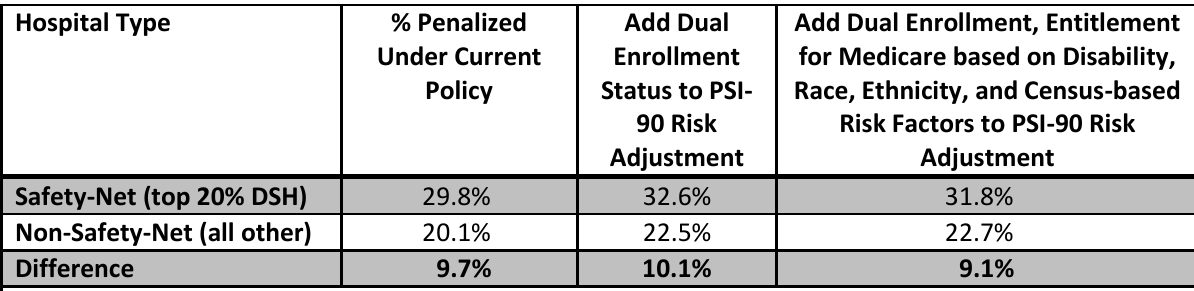
Table 6.13: Percent Penalized After Adjusting PSI-90 for Social Risk Factors